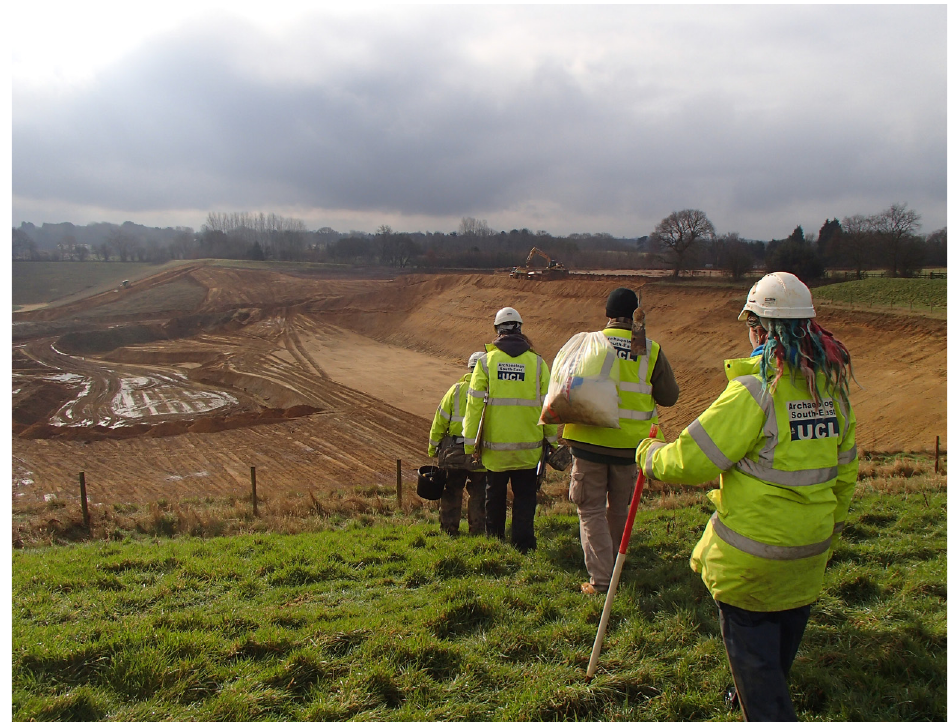
Fig. 2: Winner of the March ‘Photo of the Month’ competition. ‘Once more unto the breach…’, Charing Quarry, Kent (photo: Catherine Douglas © Archaeology